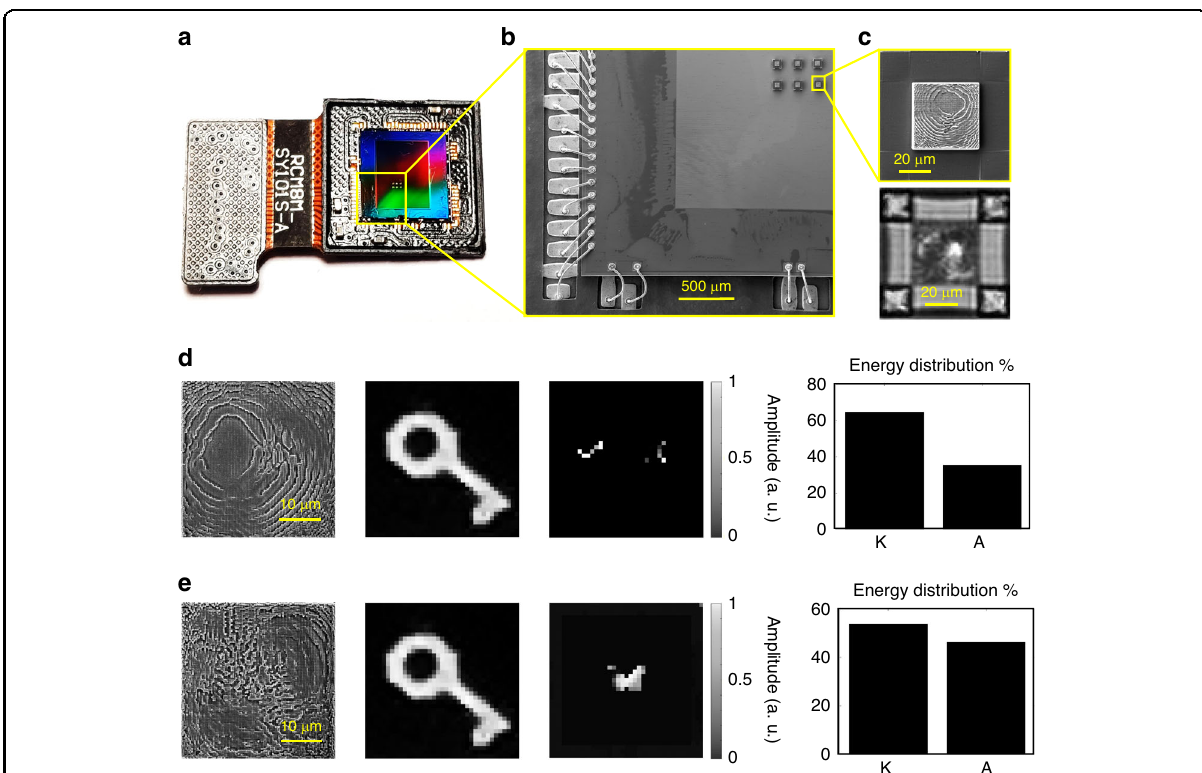
Fig. 5 Machine learning integrated on CMOS. a Photograph of the Sony IMX219 NoIR CMOS sensor with an array of 3 × 2 MLDs 3D printed via the GD-TPN method. b SEM image of the CMOS sensor surface with the MLD array. c Single MLD built on the CMOS sensor imaged with SEM (top) and directly with the CMOS sensor (bottom, scale bar 50 µm = 45 pixels). SEM image of the MLD diffractive layer, example of the experimental input fi eld, and corresponding output pattern and energy distribution percentage for the MLD-T IPS ( d ) and MLD-B IPS ( e ) designs. The complete results and performance analysis are reported in Figs. S30 and S31. The images of the input and output fi elds consist of 37 × 37 pixels (41.9 × 41.9 µm 2